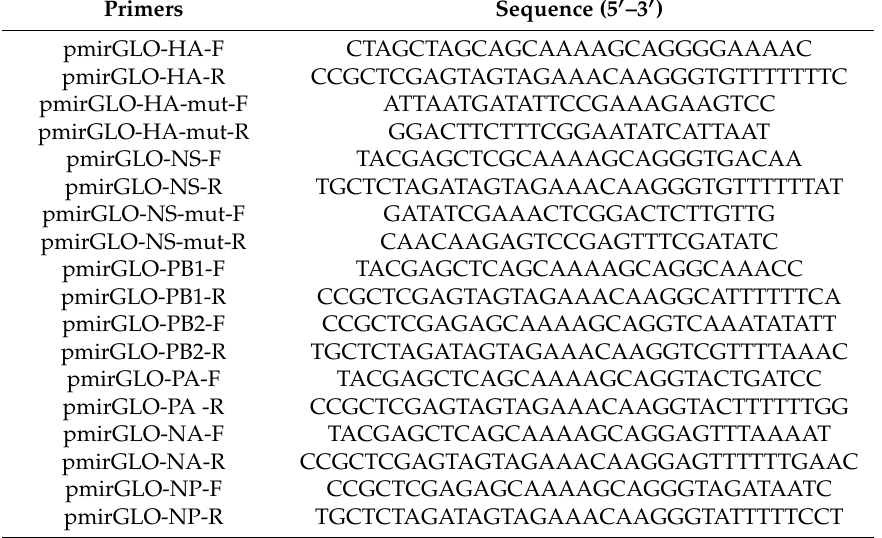
Table 3. Primers for plasmids construction used in dual-luciferase reporter assays. Primers Sequence (5 (cid:48) –3 (cid:48) )